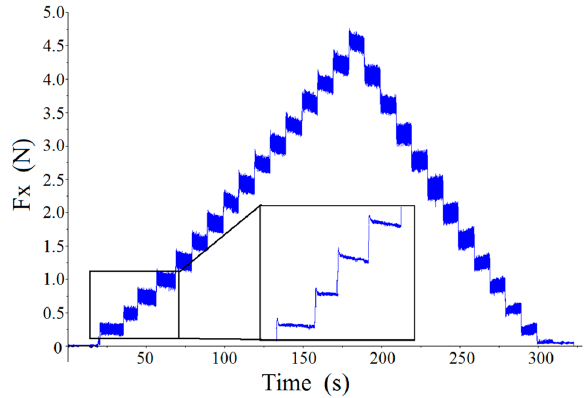
Figure 4. The loading force versus time for an 8- μ m indentation depth and a 10 s dwell period. The inset presents an expanded view of the selected region after low pass filtering.